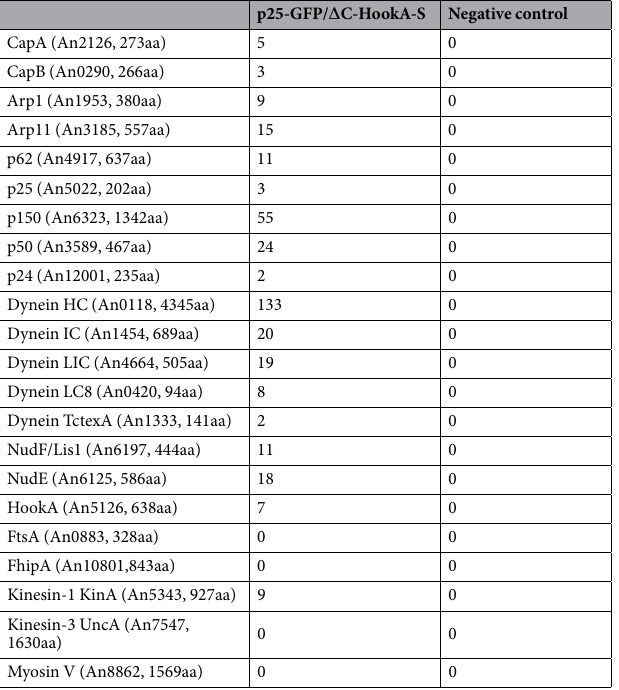
Table 1. Proteomic analysis of proteins pulled down with p25-GFP in the ∆ C-HookA-S background. Protein names and the number of unique peptides detected are listed. The negative control is a strain without any GFP tag, and the protein extracts of the two strains are processed the same way in the experiment (see Supplementary Dataset 1 for all original